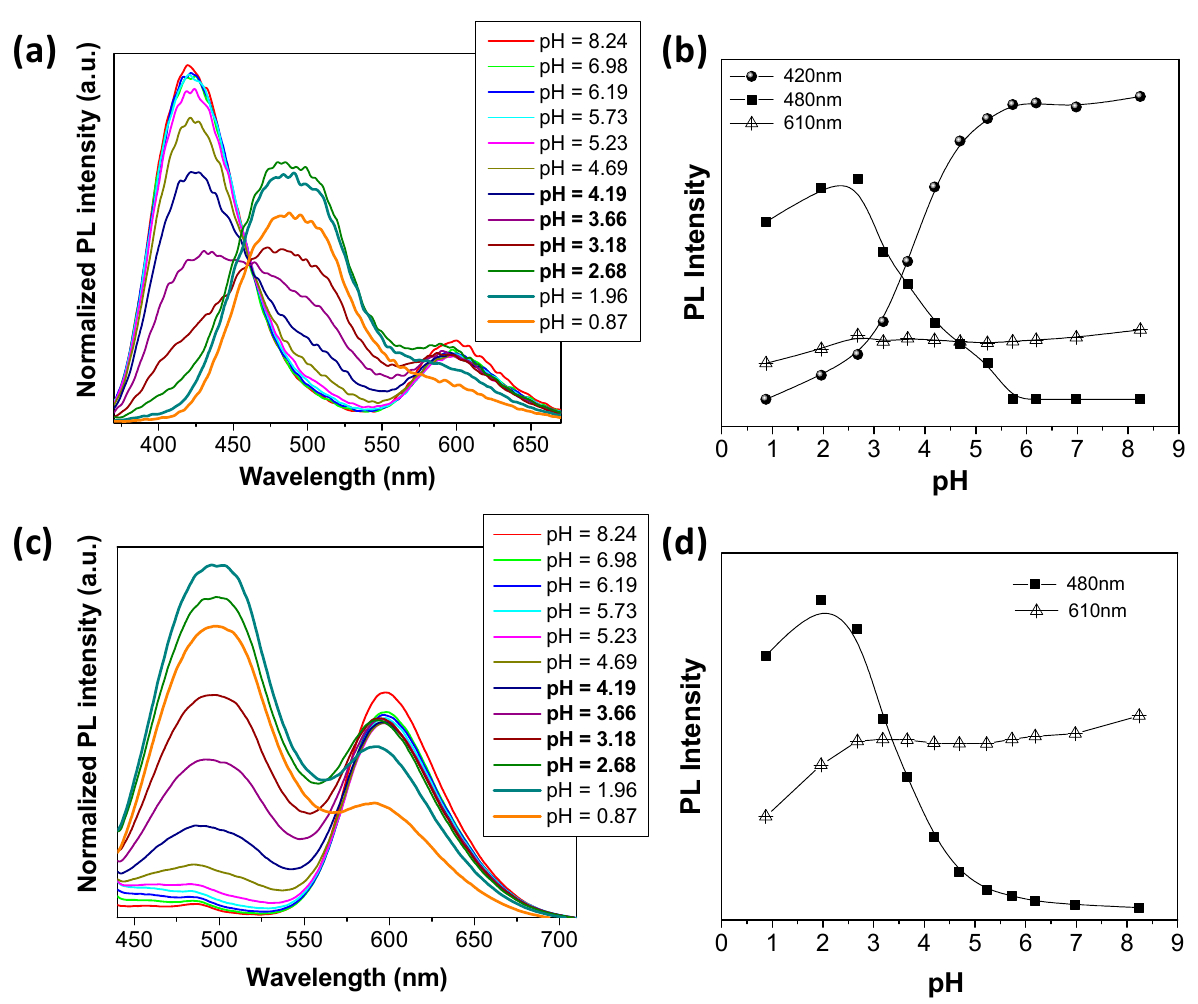
Figure 5. pH-dependence emission spectra after excitation at ( a ) 350 nm and ( c ) 400 nm for copolymer P(DMAM-co-VQPy-co-[(PPy) 2 Ir(VQPy)(PF 6 )]) P2 . ( b ) and ( d ) provide the pH-dependence of the emission intensity of the unprotonated VQPy (420 nm), protonated VQPy (480 nm) and of the Ir complexed VQPy (610 nm) species after excitation at ( b ) 350 nm and at ( d ) 400 nm. Thus herein, in agreement with previous observations by our group for similar water- soluble copolymers bearing free quinoline-based units [51,55–58], an emission peak at ~420 nm is observed in Figure 5a upon excitation of aqueous P2 solutions at 350 nm at high pH, attributed to the unprotonated form of VQPy. Apparently, for our system this blue emission does not perturb the observed color of the solution, which remains red from pH = 8 down to pH = 4.5 (Figure 6, left), due to the emitted color of the Ir(III) complex. Upon further pH decrease, free VQPy units turn to their protonated form and an emission band, reflecting a blue-green color, centered at ~480 nm is seen, while the emission band at 420 nm gradually disappears. Apart from the band at 610 nm, the evolution of both bands is clearly observable when the system is excited at 350 nm (Figure 5a), whereas only the